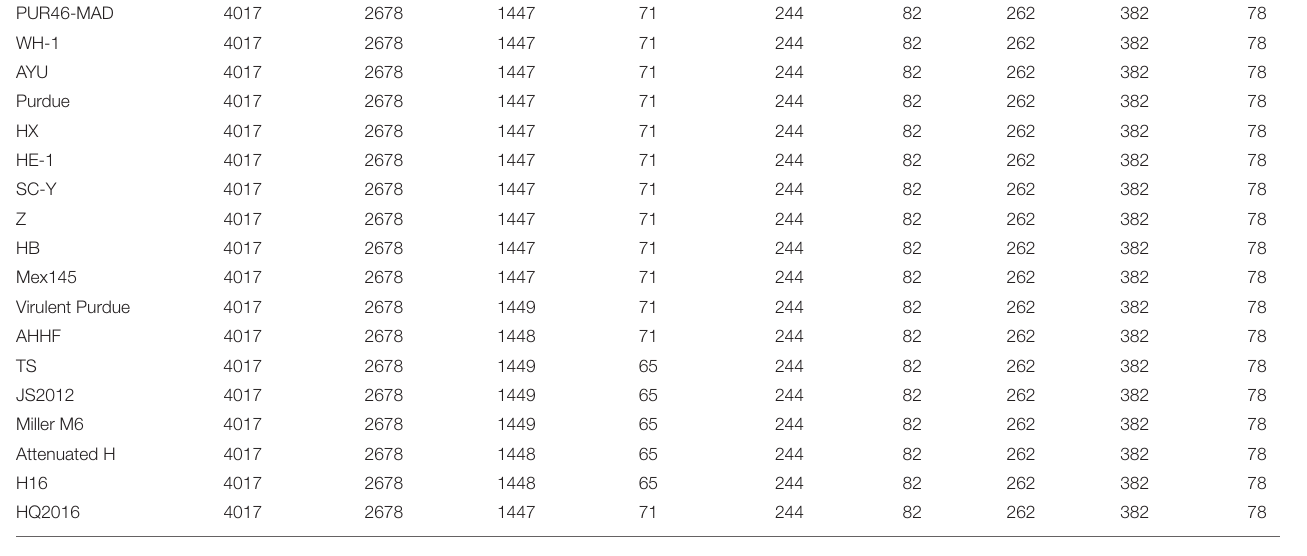
TABLE 3 | Length of amino acids in the predicted structural and non-structural proteins of TGEV strains. Strain ORF1a ORF1b S ORF3a ORF3b E M N ORF7